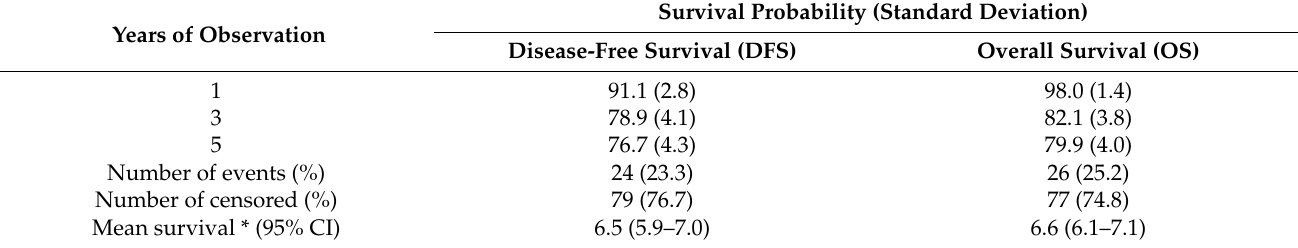
Table 3. Disease-free and overall survival in the whole group.